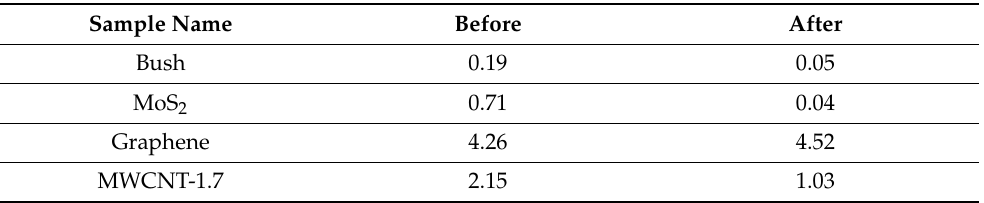
Table 6. Roughness evaluation before and after bush wear according to the addition of MoS 2 and MWCNTs.